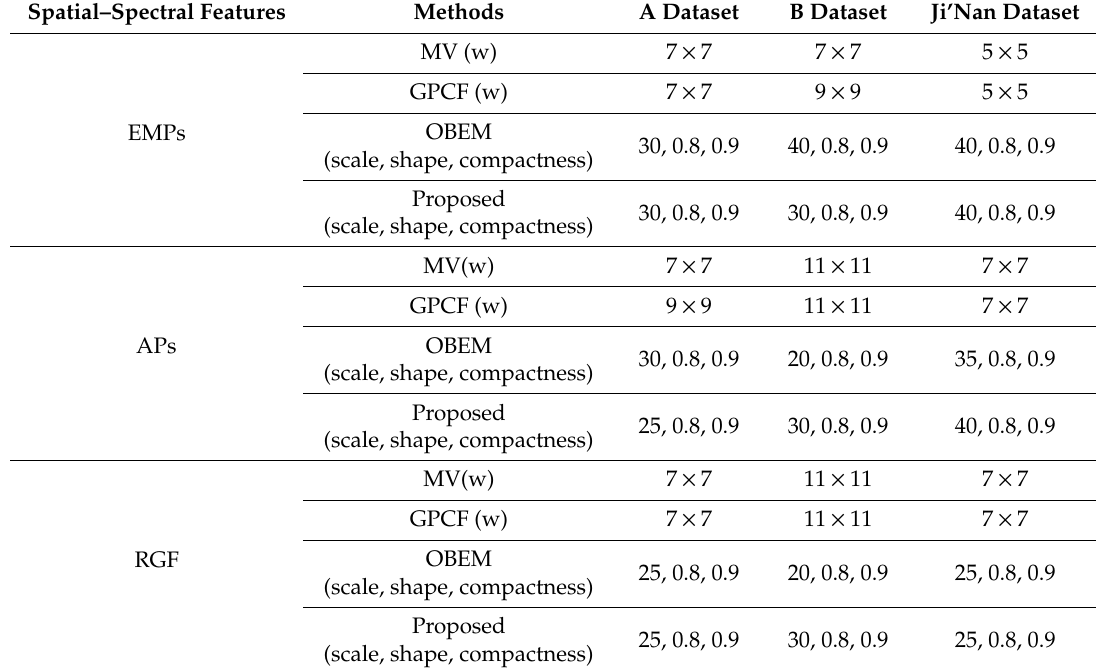
Table 4. Optimized parameter settings of the comparison between the proposed framework and the post-processing methods for di ff erent